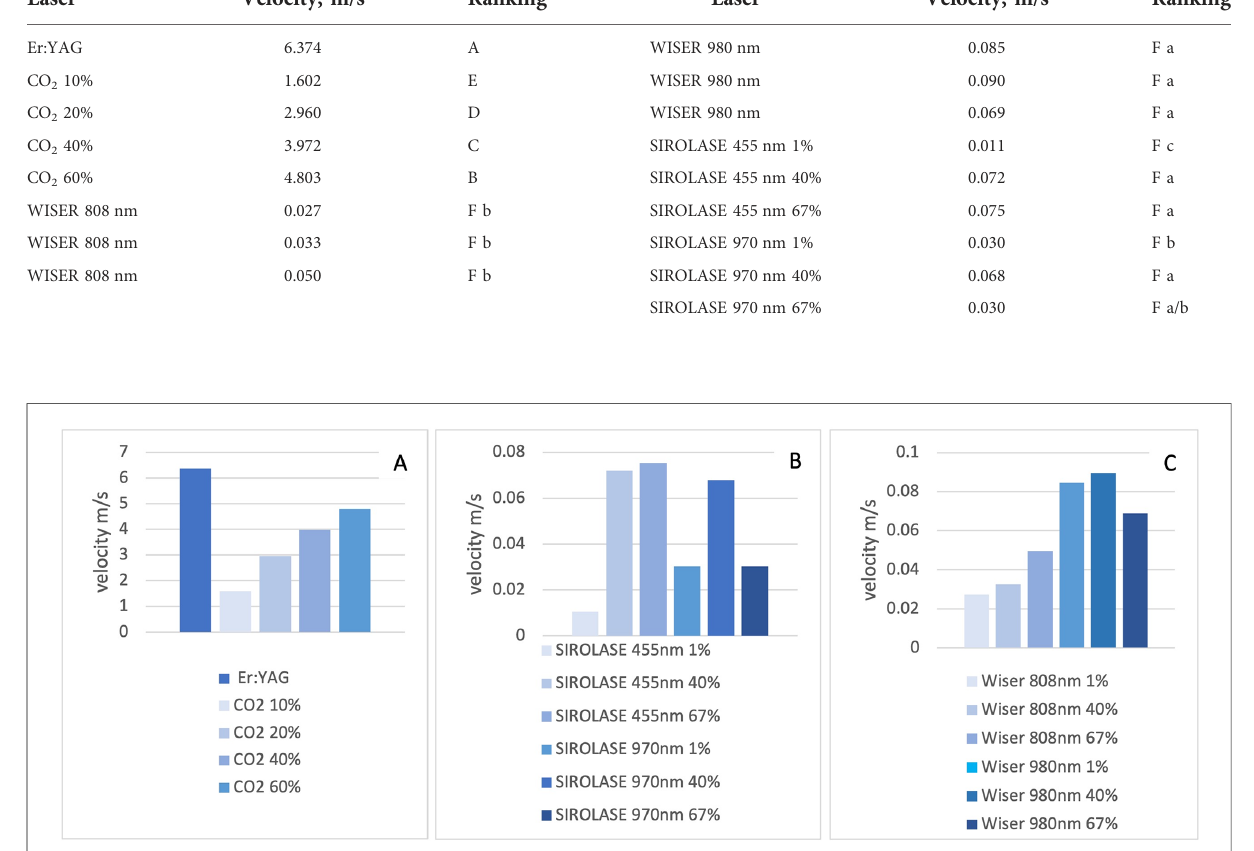
TABLE 2 Velocity of carbon particle movement after laser activation; capital letters describe a ranking of all included lasers together and small letters consider exclusively a ranking of the diode lasers (WISER and SIROLASE). Laser Velocity, m/s Ranking Laser Velocity, m/s Ranking Er:YAG